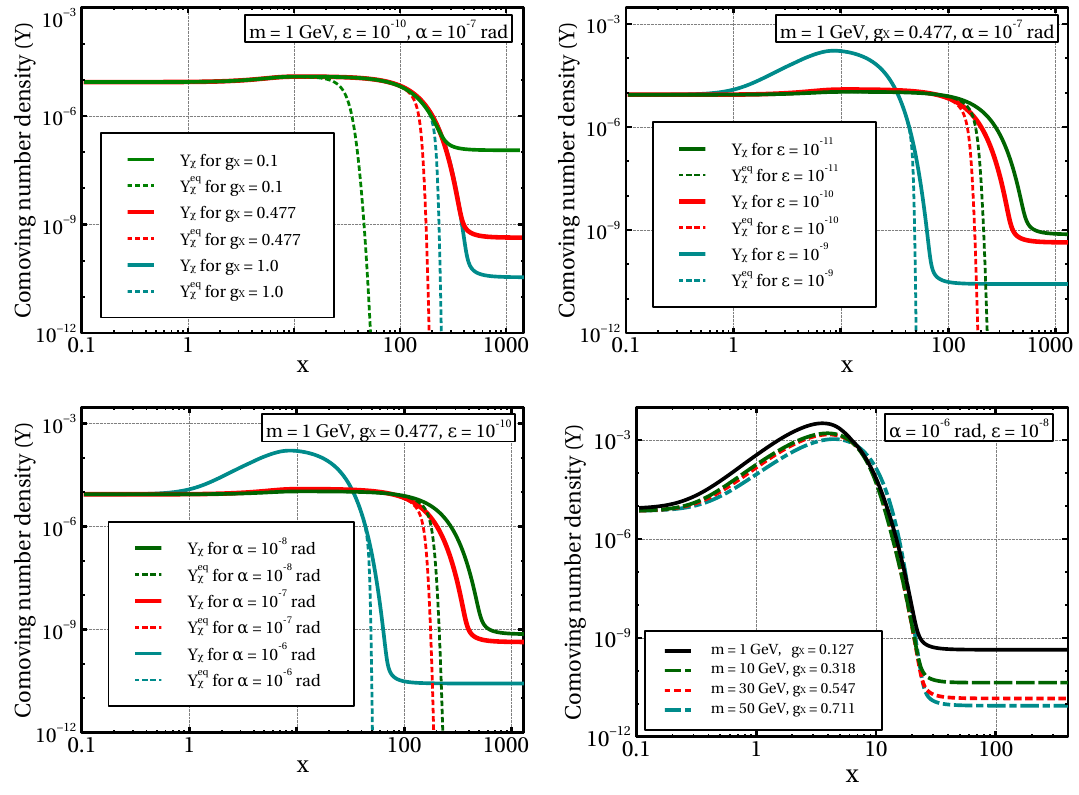
Figure 7 . Dependence of various model parameters on the comoving number